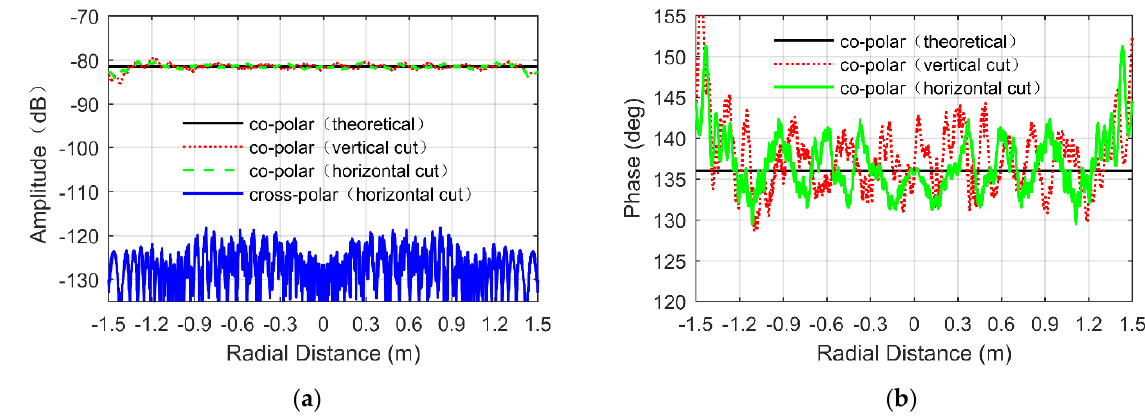
Figure 5. PO + PTD one-dimensional simulated results of the designed tri-reflector CATR with standard quadric surfaces when illuminated by a shaped feed at 100 GHz. ( a ) Co- and cross-polar amplitude; ( b ) co-polar phase.